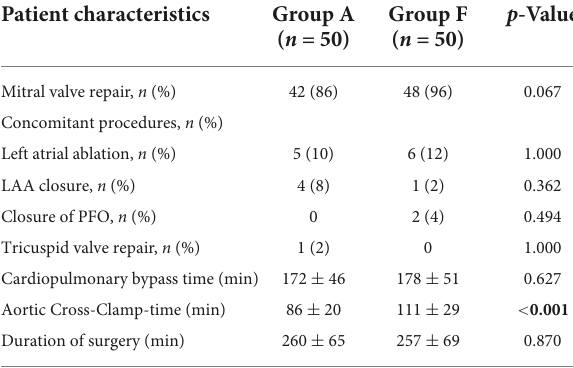
TABLE 2 Intraoperative patient data.